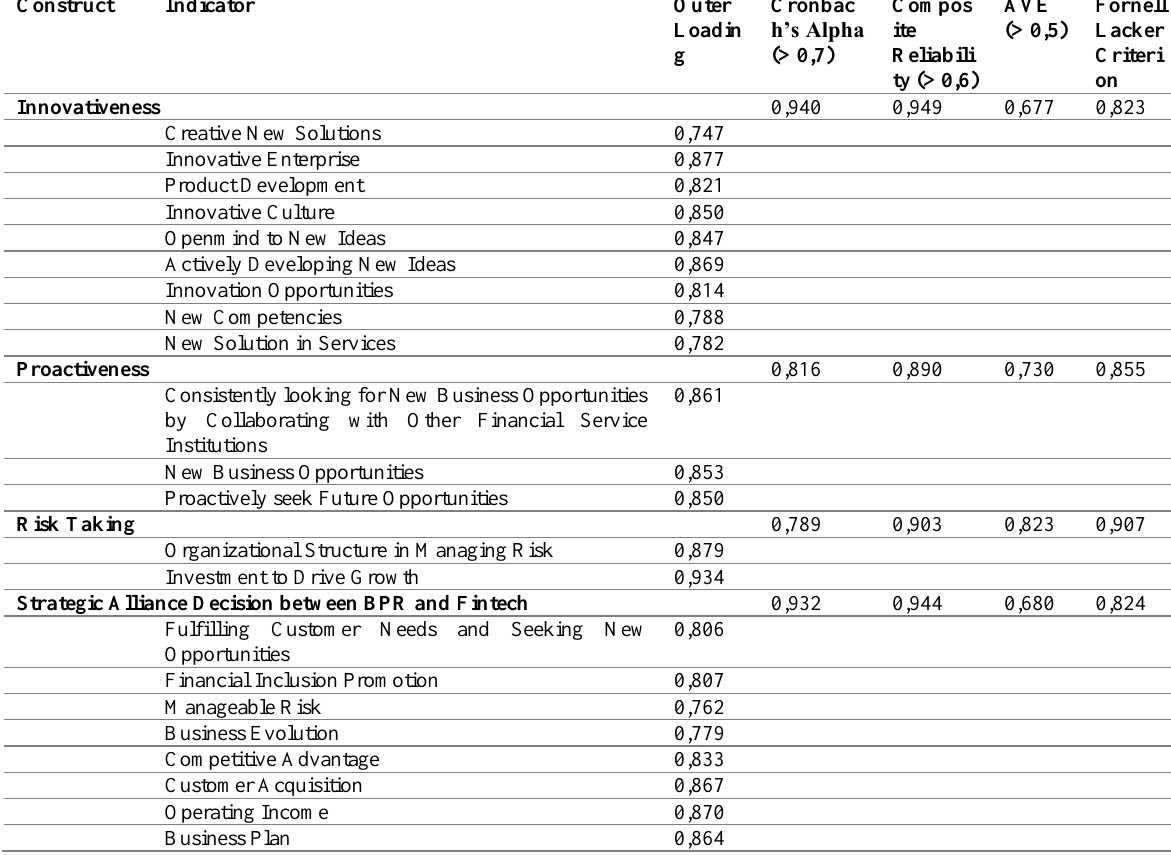
Table 1: Measurement